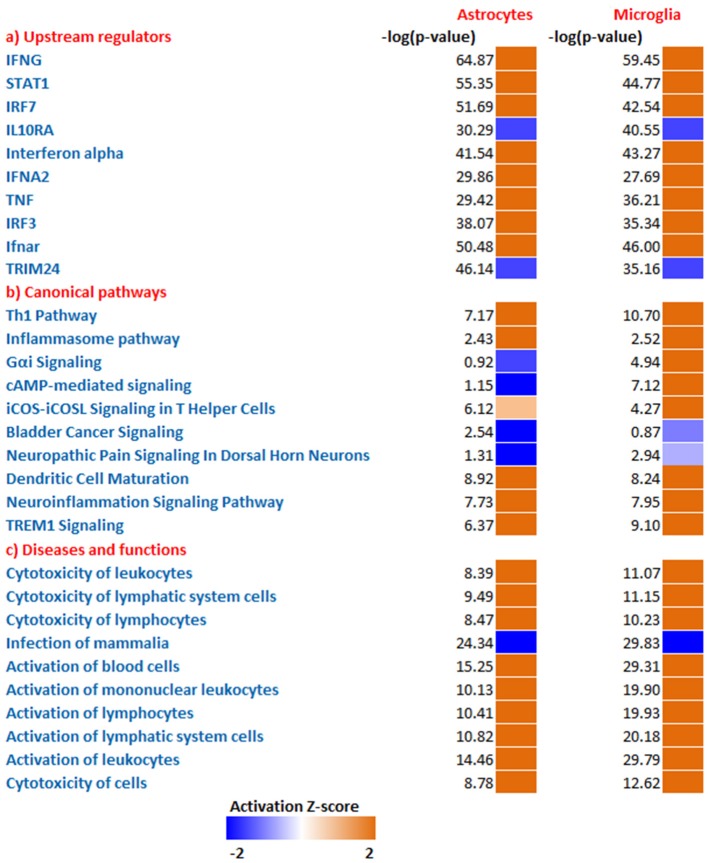
Comparative analysis all DEGs enriched from microglia and astrocytes. Using IPA software from Ingenuity systems, we performed this comparative analysis to determine top (a) upstream regulators (b) canonical pathways (c) Disease and functions from the enriched gene sets. The heat maps were sorted using the trend and activation Z-score. Orange and blue boxes represent positive and negative Z-scores, respectively.